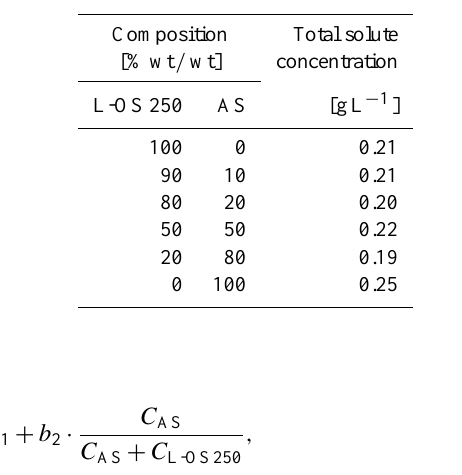
Table 2. Solutions of L-OS 250, AS and mixtures hereof for mea- surement of hygroscopic growth factor and CCN activation.